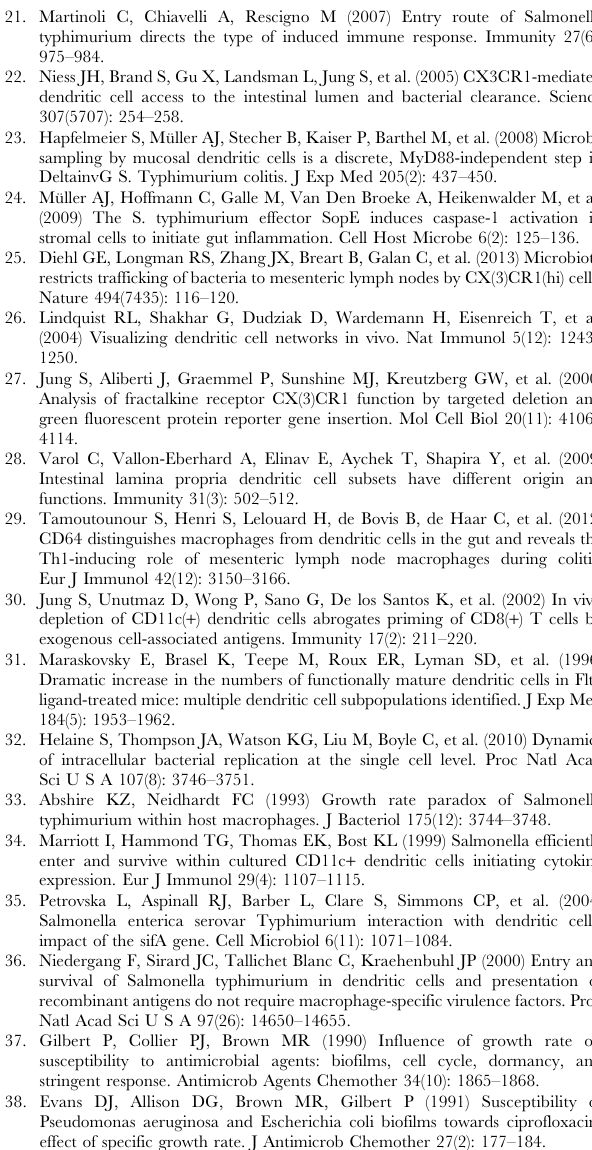
Table S2 Raw data used for modeling in vivo growth and killing rates under ciprofloxacin treatment. The table shows the raw data gained from mouse experiments, which were used to fit the mathematical model. Each row shows the absolute number of S. Tm carrying a specific WITS-tag from one mouse cLN, total cLN cfu (tagged and untagged S. Tm), and number of days of infection. Ciprofloxacin treatment (2 6 62 mg/kg/d by gavage) was started day 1 p.i. for all mice. This dataset is also contained in the R-package provided as Protocol S1. Text S1 Documentation of the R-package kaiser14pb in .pdf